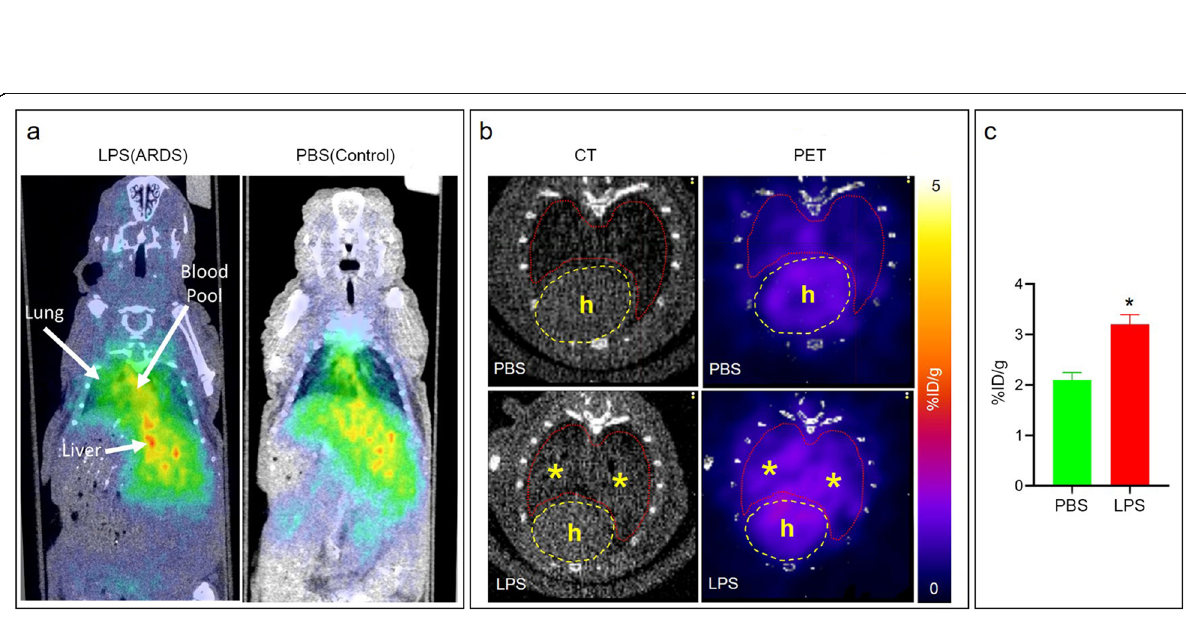
Fig. 4 68 Ga-albumin PET uptake in an LPS model of ARDS. a representative whole body coronal 68 Ga-albumin PET/CT images 4 h after injection demonstrating significantly increased lung activity in LPS treated lungs compared to control, which only demonstrated physiologic uptake in the blood pool (heart) and liver. b quantification of 68 Ga-albumin lung uptake on PET/CT axial images was derived by drawing ROIs on the CT image (*) and calculating the %ID/g from the corresponding PET scan. c 68 Ga-albumin lung uptake calculated from PET/CT images (as shown in b ). ROIs from lungs were compared between mice treated with intranasal LPS ( n = 4) and intranasal PBS ( n = 3), demonstrating significantly higher uptake in lungs of mice treated with LPS. *, p <